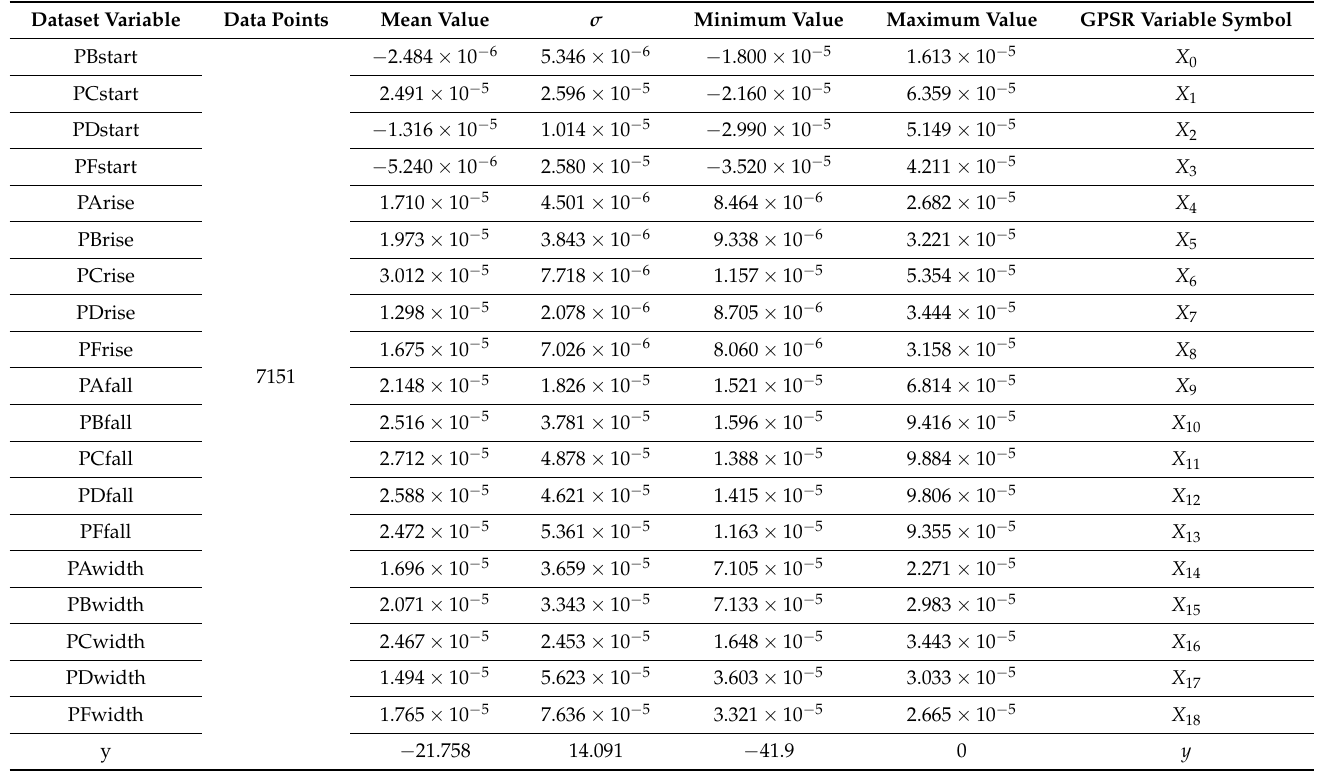
Table 2. The results of the statistical investigation of dataset variables including the GSPR vari- able